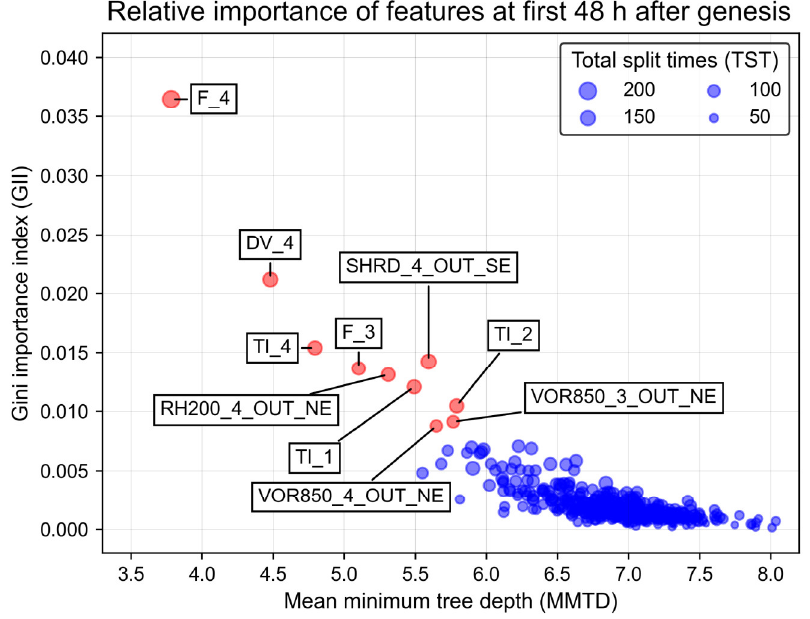
Figure 10. As in Figure 6, but for features during the first 48 h after genesis in step